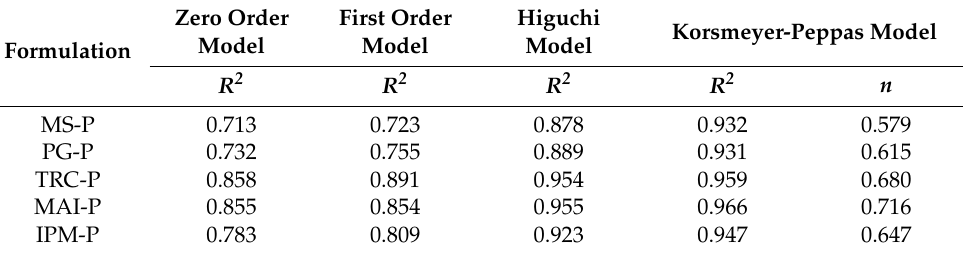
Table 6. Drug release kinetics models of MS-loaded patches with different solvents (PG: propylene glycol; TRC: Transcutol ® P; MAI: Maisine ® CC; IPM: isopropyl myristate; MS: methyl salicylate; MS-P: patches with drug but without solvent; -P: patches with drug and solvent).